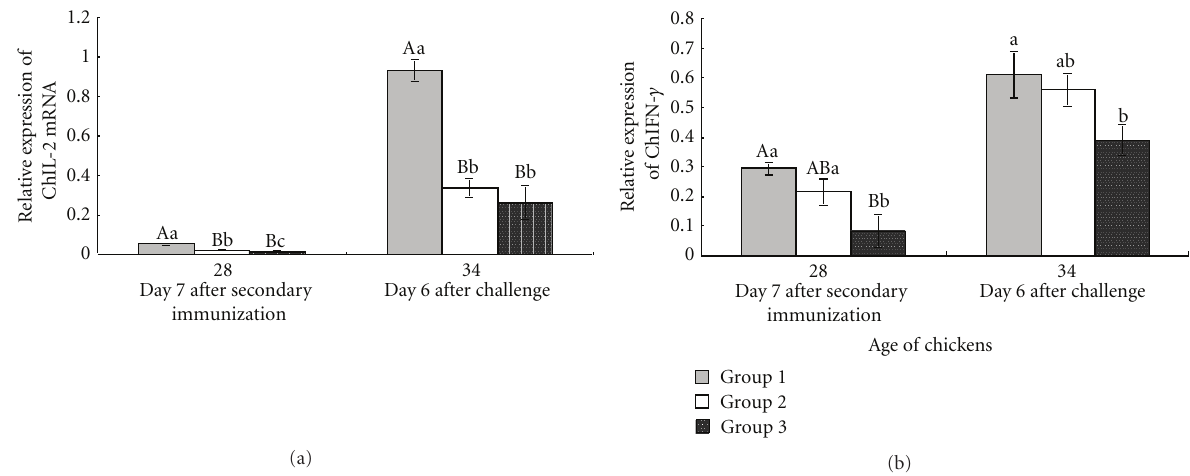
Figure 3: E ff ect of immunization with pcDNA-3-1E-mChIL-15 on ChIFN- γ and ChIL-2 mRNA levels. Seven-day-old chickens were divided into three groups. Chickens in each group were, respectively, intramuscularly immunized with 100 μ g pcDNA-3-1E-linker-mChIL-15 (group 1), 100 μ g pcDNA3.1 (group 2), and sterile TE bu ff er (pH 7.6) (group 3) at 14 and 21 days of age. All chickens were inoculated orally with 5 × 10 4 sporulated oocysts of E. acervulina at 28 days of age (day 7 after secondary immunization). The level of splenic mRNAs encoding ChIFN- γ and ChIL-2 was measured by real-time PCR at 28 and 34 days of age (day 6 after challenge). The cytokine mRNA levels of individual chicken in each group were divided by mRNA levels of GAPDH of the same chicken to normalize the relative mRNA levels of ChIL-2 and ChIFN- γ . Data were expressed as mean ± standard errors ( n = 5 per group). Highly significant di ff erence ( P < 0 . 01) between bars not sharing the same capital letters in each time point. Significant di ff erence ( P < 0 . 05) between bars not sharing the same small letters in each time